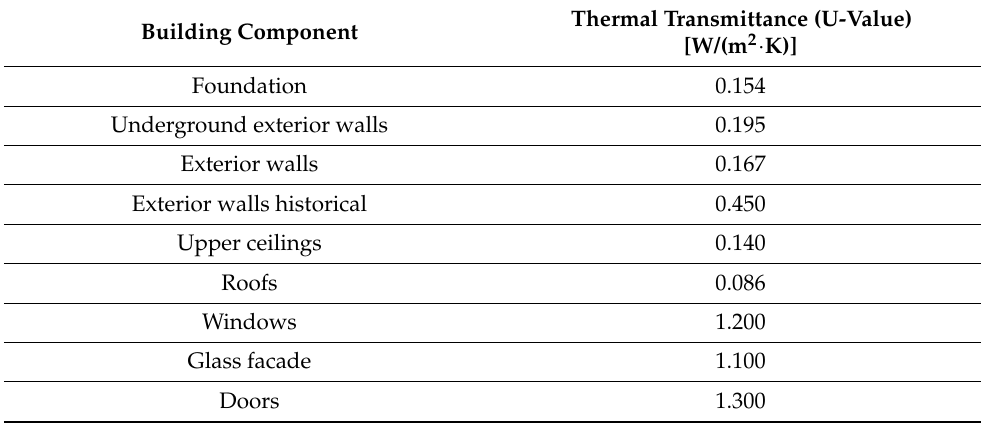
Table 1. U-values of the building